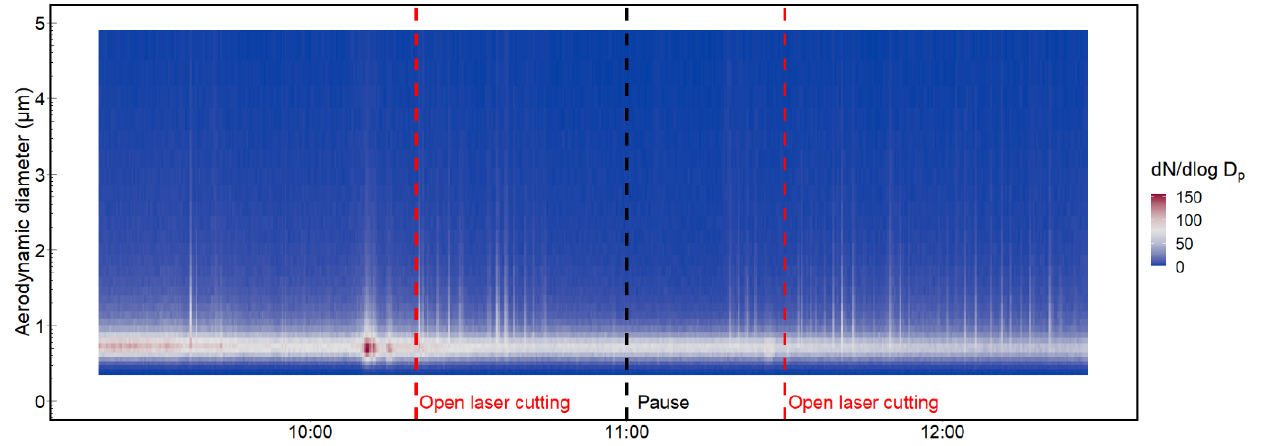
Figure 5. Particle size and number concentrations measured with APS during laser cutting. The red line indicates the start of cutting with the open laser and the black line indicates the stop. The closed laser cutter was operating in the background throughout the entire time.